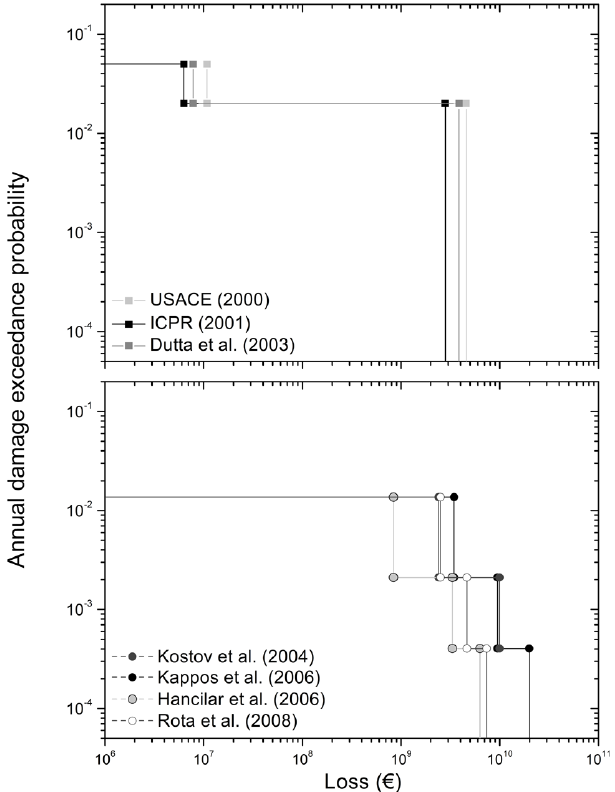
Fig. 15. Expected losses as a function of exceedance probabil- ity calculated with different vulnerability models for (a) flood risk and (b) seismic risk. Value of flood risk under the curve is 5629778 C, 7735953 C, and 9643805 C for ICPR (2001), Dutta et al. (2003) and USACE (2003) vulnerability models, respectively. Value of seismic risk under the curve is 51998532 C, 63897207 C, 17818522 C, 39885784 C for Kostov et al. (2004), Kappos et al. (2006), Hancilar et al. (2006), and Rota et al. (2008) vulnera- bility models,